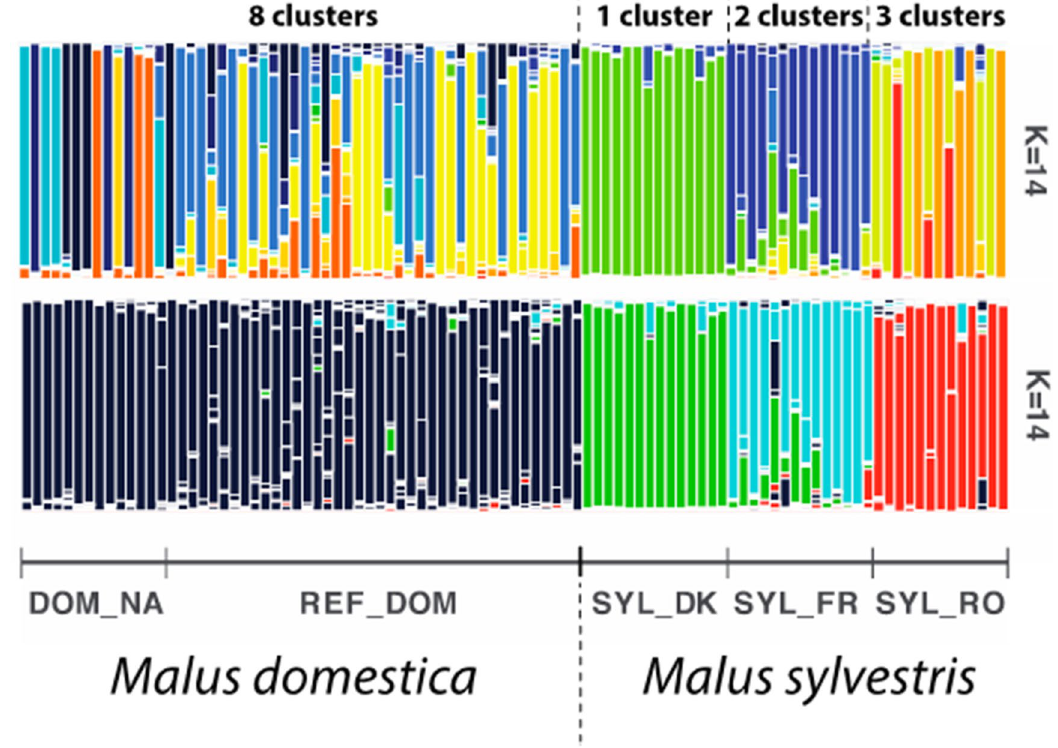
Figure 1. Assessment of the genetic status of the wild and cultivated apple seedlings ( Malus sylvestris and Malus domestica , respectively) used in this study. Upper barplot: Population structure inferred with STRU CTU RE for K = 14 for the Romanian, French, Danish M. sylvestris seedlings, and the M. domestica seedlings. STRU CTU RE detected eight cultivated gene pools, including the 40 M . domestica reference cultivars (DOM_REF, 40 reference M. domestica ) and the cultivated apple seedling used in this study (DOM_NA, N = 14). The Romanian seedlings (SYL_RO, N = 13) clustered into three clusters (orange, red and yellow colors), the French seedlings (SYL_FR, N = 14) into two clusters (light and dark blue color), and the Danish seedlings (SYL_DK, N = 14) into one cluster (green color). Lower barplot: For the sake of visualization the eight cultivated gene pools were coloured in dark blue (lower barplot), the three Romanian clusters in red, the two French clusters in light blue, and the Danish stayed light